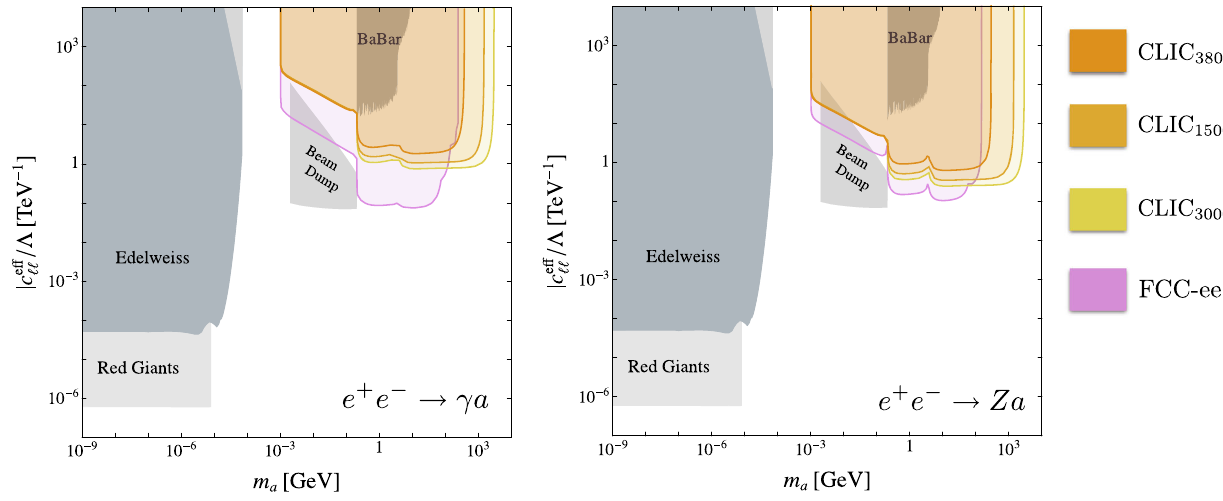
Fig. 9 Projectedexclusioncontours forsearchesfor e + e − → γ a → γ(cid:10) + (cid:10) − (left)and e + e − → Za → Z vis (cid:10) + (cid:10) − (right)forfuture e + e − colliders, and Br ( a → (cid:10) + (cid:10) − ) = 1. The constraints from Fig. 5 are in the background. The sensitivity regions are based on 4 expected signal events